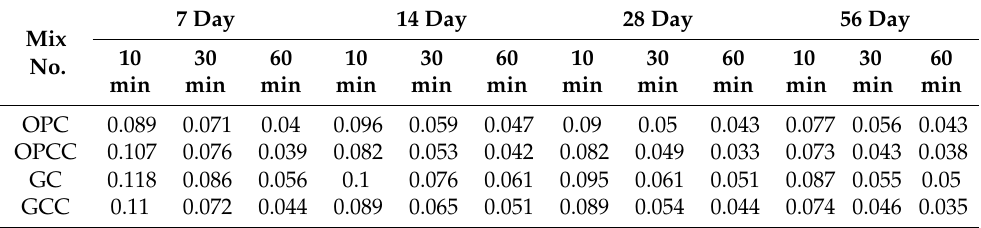
Table 15. Initial surface absorption of concrete (ml/m 2